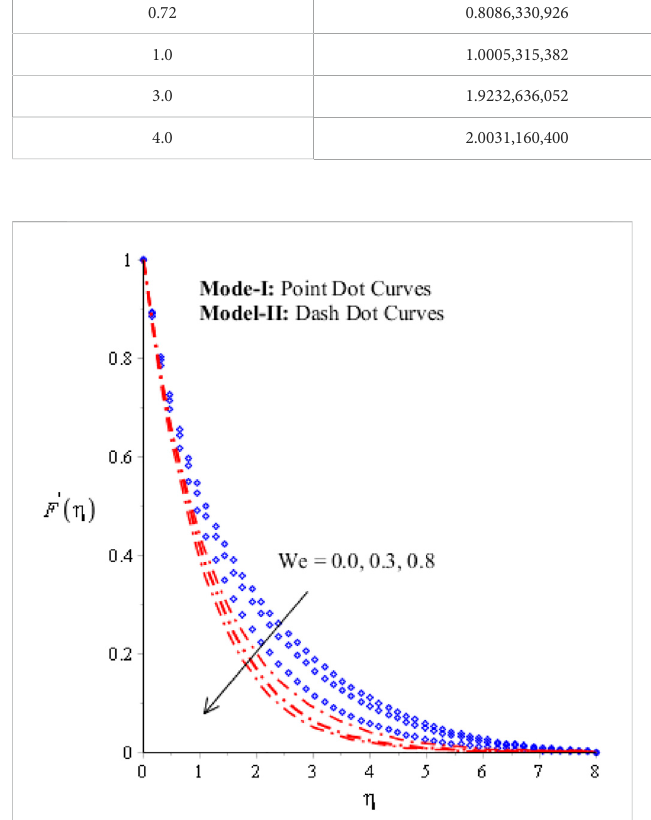
TABLE 4 Validation results for Nusselt number based on published data (Muhammad and Nadeem, 2017) when H t (cid:2) 0 , β (cid:2) ϵ (cid:2) 0 (cid:2) Λ (cid:2) 0 , χ (cid:2) 0 , λ (cid:2) 0 , α (cid:2) 0 . 3 ,n (cid:2) 0 . 2 ,Re (cid:2) 3 . 0 ,We (cid:2) 2 . 0 ,Sc (cid:2) 0 . 4 ,K c (cid:2) − 1 . 5 , and τ (cid:2) 0 . 3 . Pr